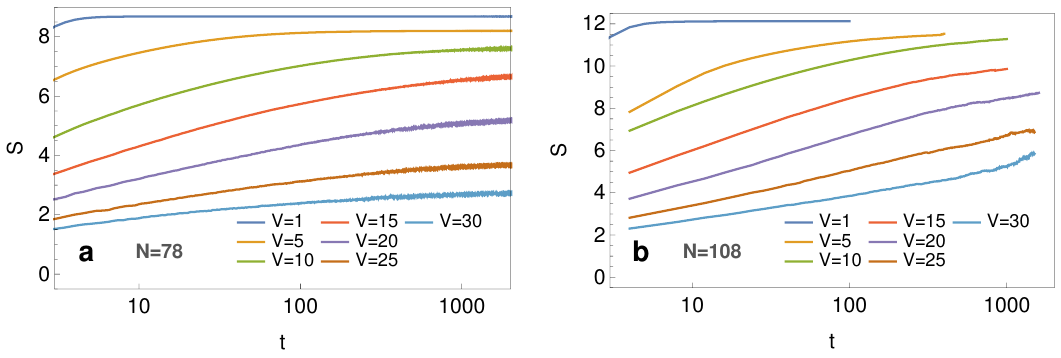
Figure 10: Asymptotic value of modulus-squared imbalance at long times, as a func- tion of disorder. Inset. Coefficient I function of disorder.